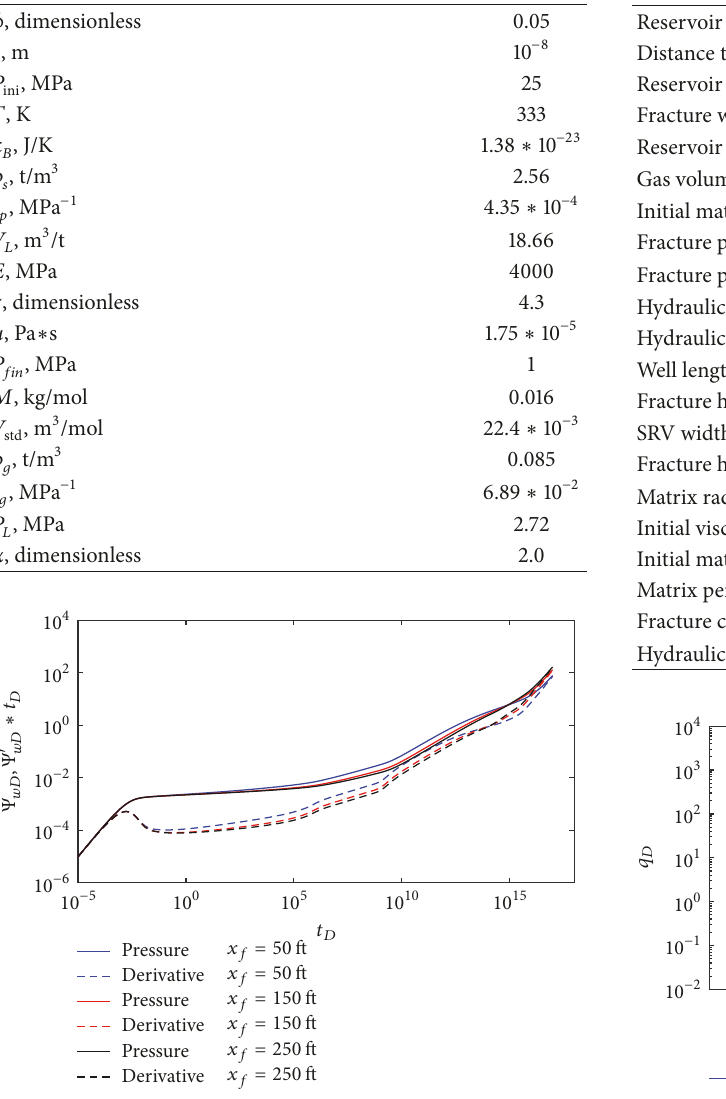
Figure 3: Effect of hydraulic fracture half-length on pressure.